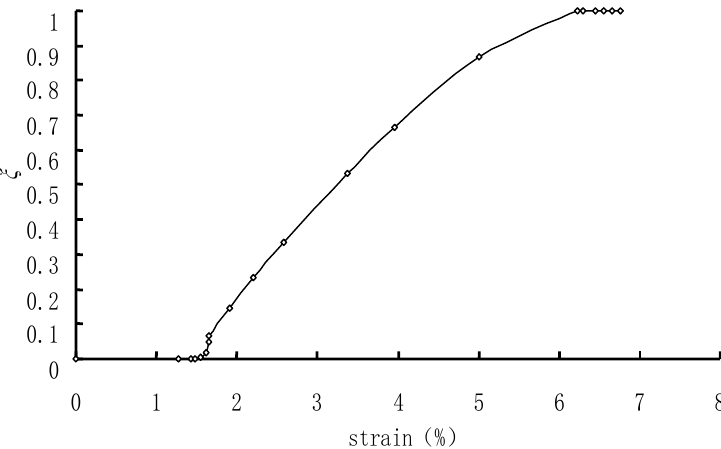
Figure 3. The variation of tension–strain versus martensite volume fraction (see Li, 2005 [18]). ξ stands for the volume fraction of martensite under uniaxial tension. The volume fraction of martensite is obtained from the finite element analysis when the strain varies from 0%–1.6%; elsewhere it is obtained by experimental observation.